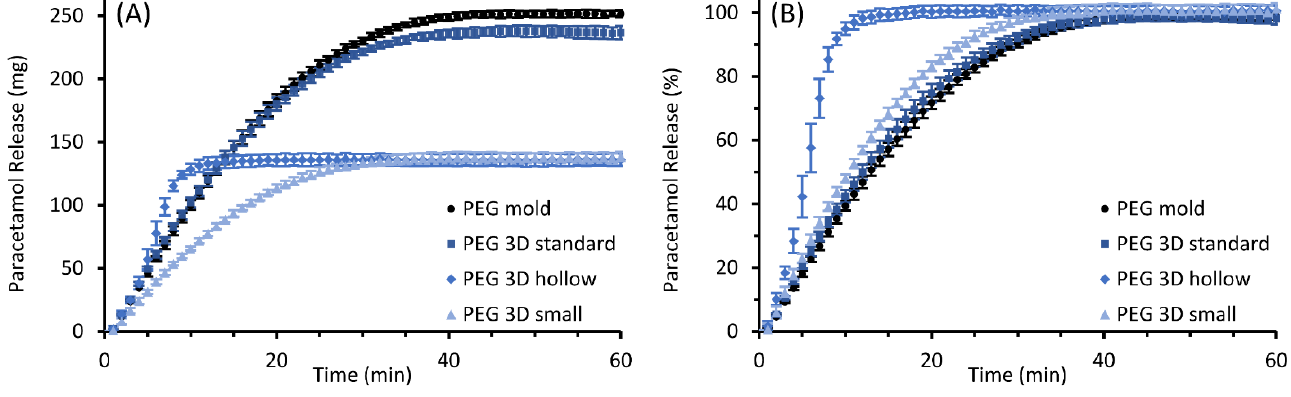
Figure 9. Paracetamol release profiles of molded and 3D printed (“standard”, “hollow”, and “small” design) suppositories based on PEG; mean ± SD, n = 6. Diagram ( A ) shows the cumulative amount of the released drug as mass and diagram ( B ) as the proportion of the expected total amount of 10% ( w / w ) paracetamol of the individual suppository mass.